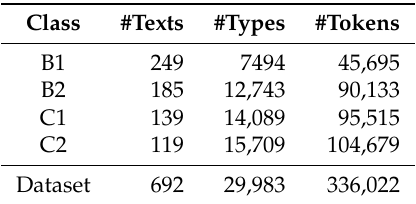
Table 1. Characteristics of the